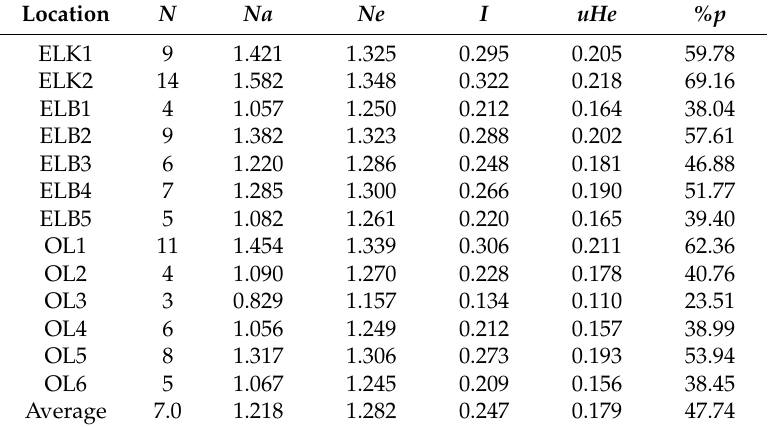
Table 3. Genetic diversity parameters in the studied locations of S. purpurea based on all DNA marker systems (RAPD, AFLP and ISSR). N Na